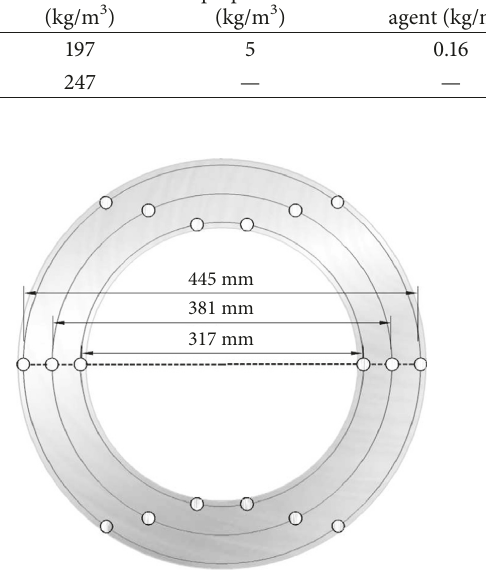
Figure 3: Template for positioning of the DEMEC point discs on the free ring-shape